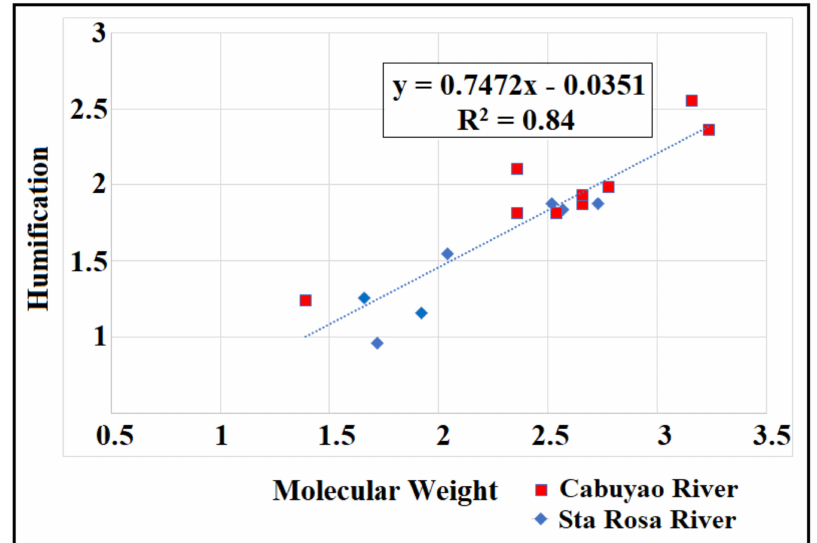
Figure 8. Scatter plot of Molecular weight vs. humification in SR and CR. A strong correlation between C:T and A:T ratios [72] was presented in Table 7 to describe the relative amount of humic-like DOM versus fresh-like DOM. Using these ratios, we can infer those higher values indicate a higher proportion of degraded material [72]. Low values in December 2019 for all sampling stations were measured due to stormwater run-off before sampling. For the two rivers, the degree of humification and DOM composition are highly influenced by the surrounding land use (Table